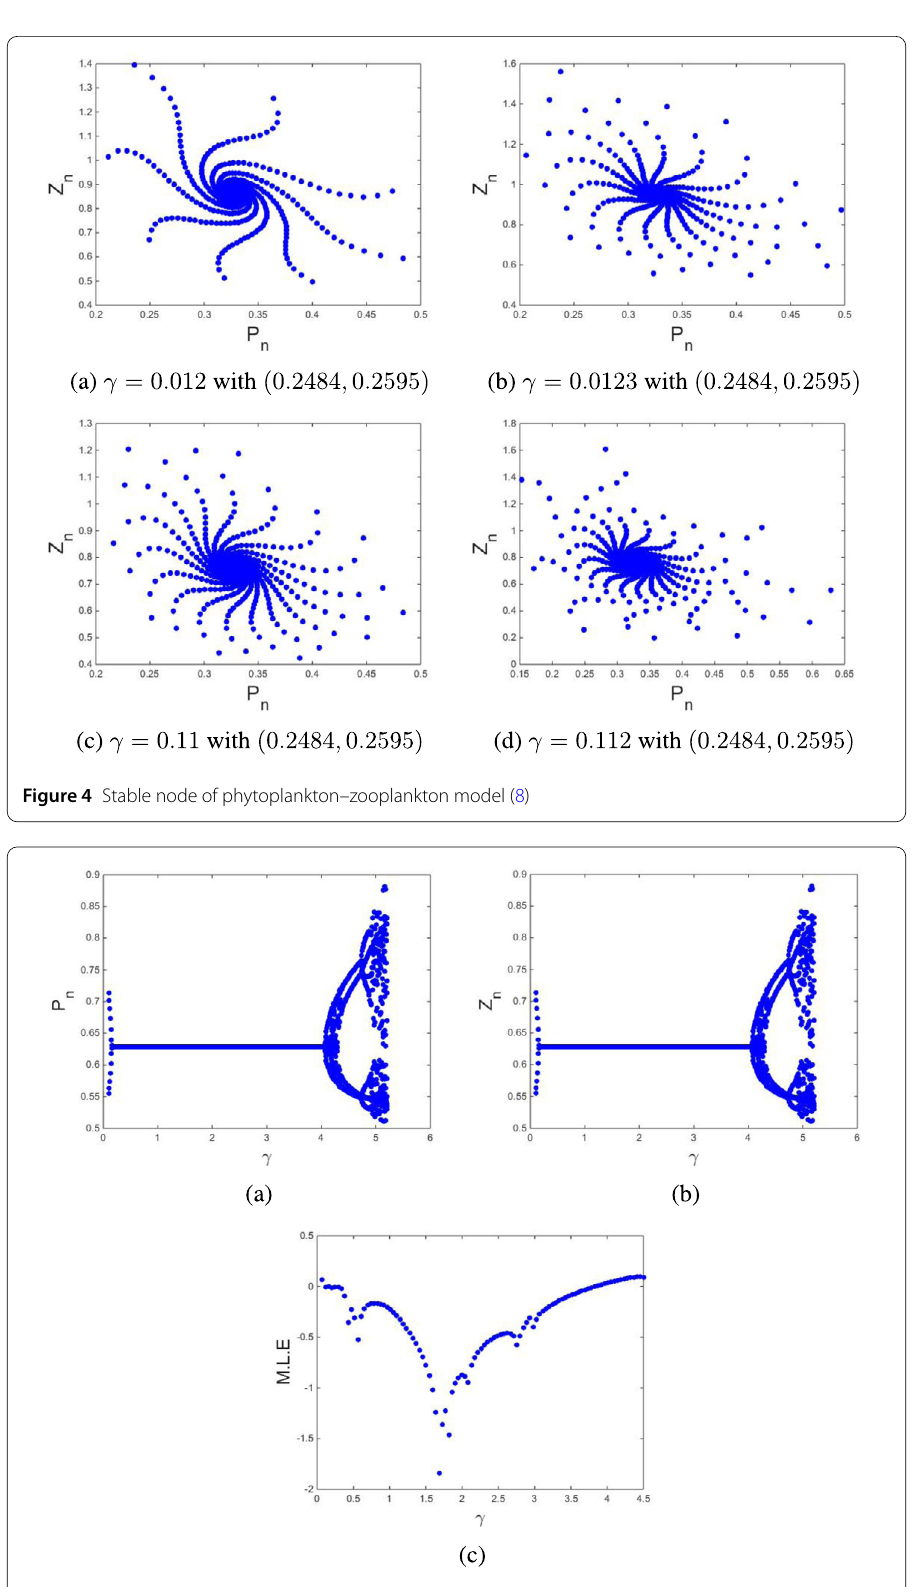
Figure 5 5( a )–5( b ) Flip bifurcation diagrams of phytoplankton–zooplankton model (8) with γ ∈ [0.1,5.2] 3(b) Maximum Lyapunov exponents corresponding to 5( a )–5( b ) with